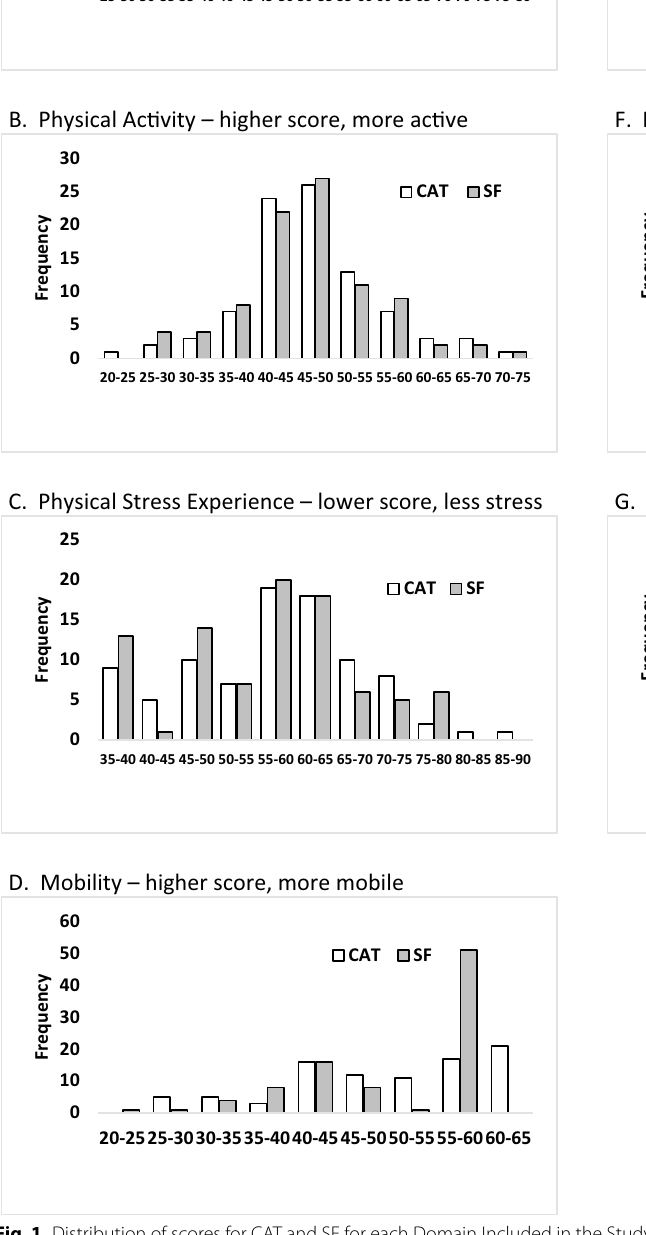
Fig. 1 Distribution of scores for CAT and SF for each Domain Included in the